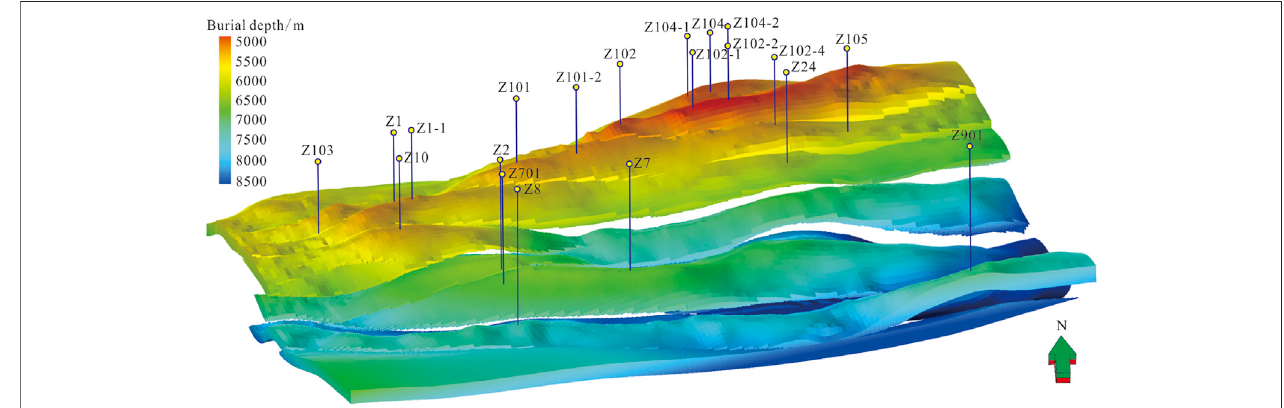
FIGURE 8 | Three dimensional structural model of Cretaceous reservoir in the Bozi gas fi